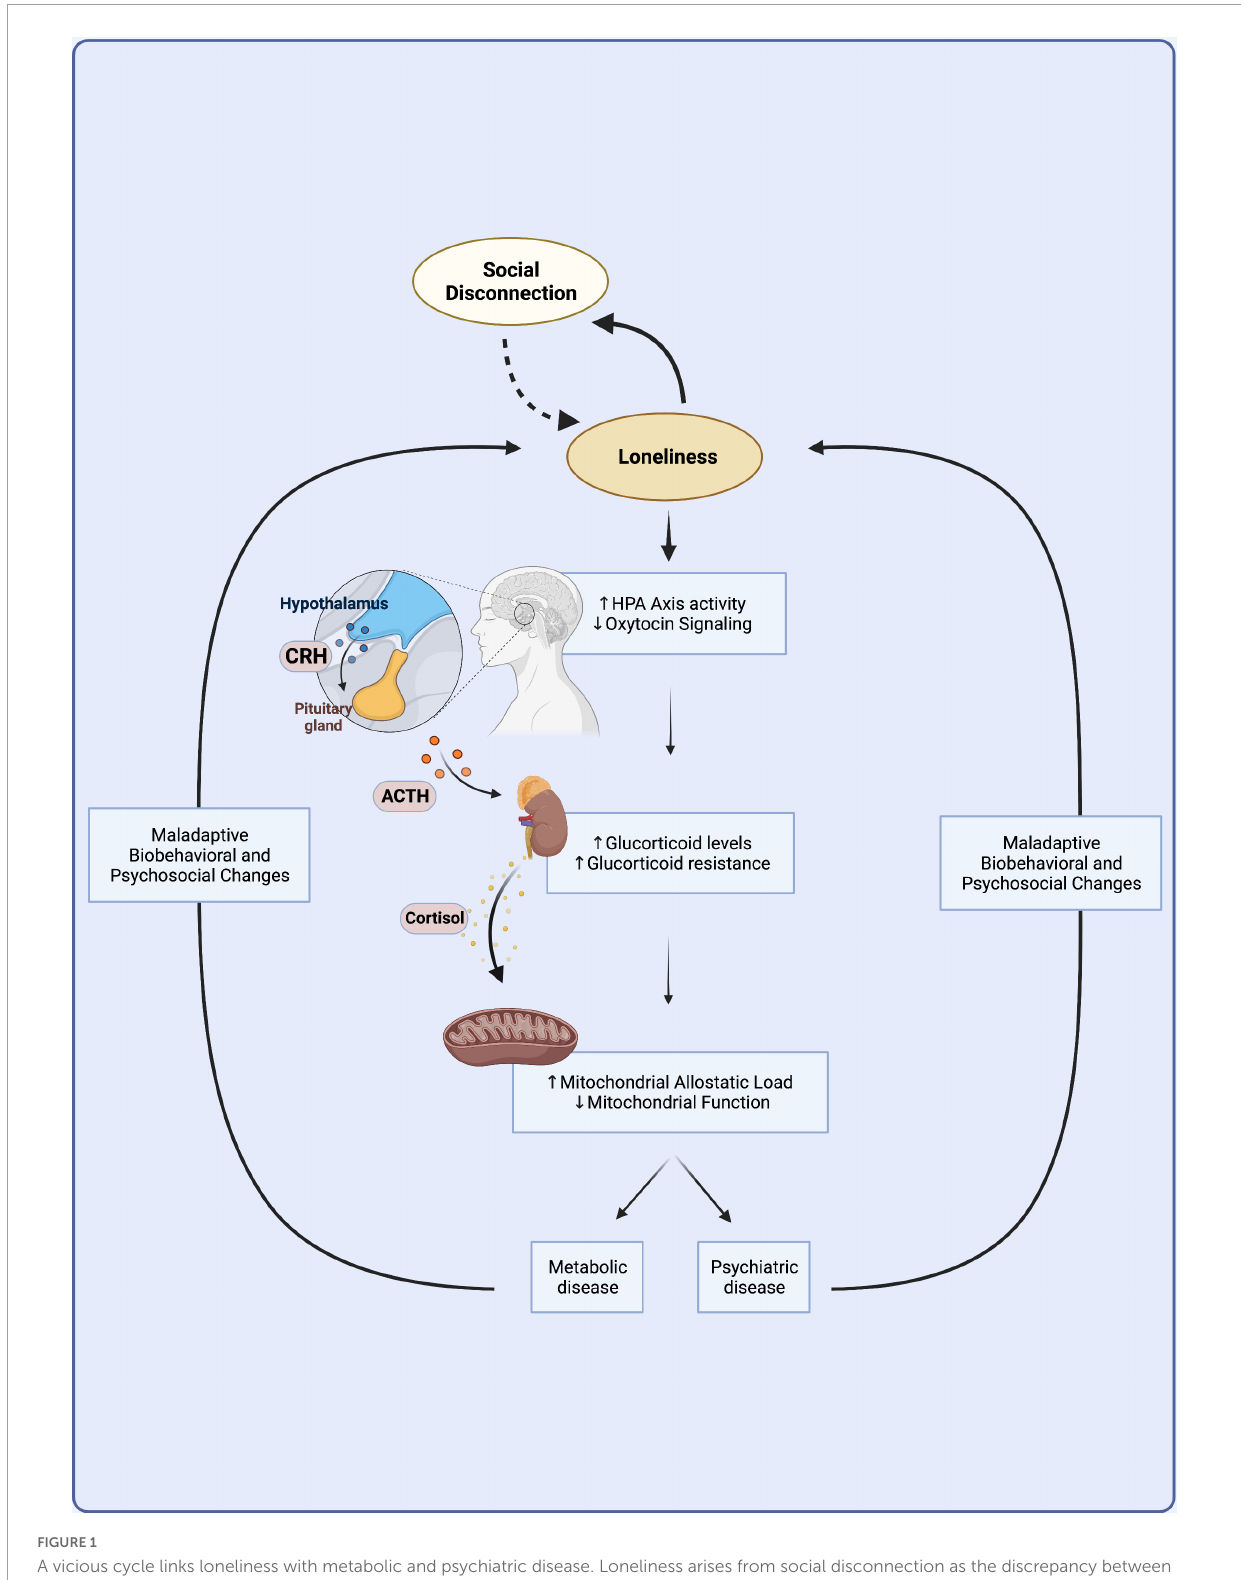
FIGURE1 A vicious cycle links loneliness with metabolic and psychiatric disease. Loneliness arises from social disconnection as the discrepancy between desired and actual levels of social connection. Loneliness might lead to further social isolation through maladaptive biobehavioral changes and increased stress sensitivity in a vicious cycle independent of disease. Chronic loneliness is a prolonged psychosocial stressor that becomes embedded in the body through the overactivation of the hypothalamic-pituitary-adrenal axis, which leads to chronically elevated levels of circulating glucocorticoids. Chronic HPA axis hyperactivity leads to glucocorticoid resistance and mitochondrial dysfunction that culminate in immunometabolic changes common to the etiologies of many metabolic and mental illnesses. Biobehavioral and psychosocial changes observed in metabolic and mental illness might contribute to a vicious cycle furthering loneliness and its adverse downstream neuroendocrine and immunometabolic consequences. HPA, hypothalamic-pituitary-adrenal; CRH, corticotrophin releasing hormone; ACTH, adrenocorticotropic hormone. Created with